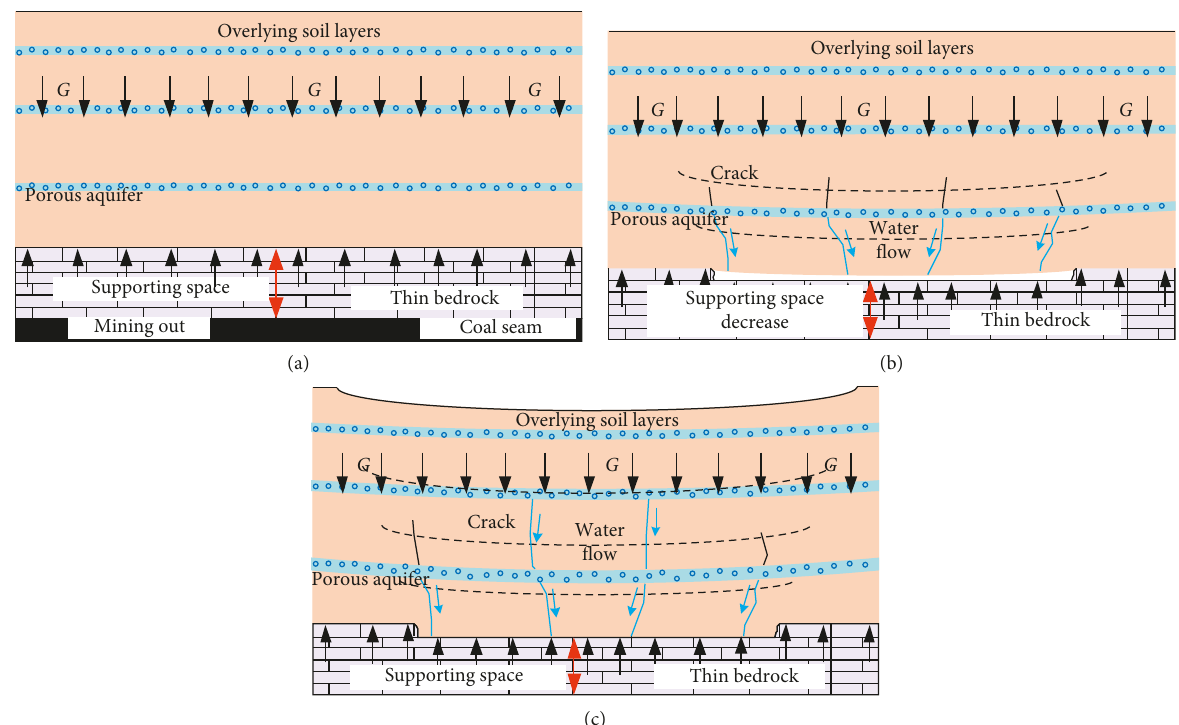
Figure 4: Failure process of the overlying soil layers of thin bedrock: (a) natural state; (b) coal seam mining out ⟹ thin bedrock collapses or fractures ⟹ supporting space decreases and soil layer subside; (c) overlying soil layers recompact on the collapsed thin bedrock.